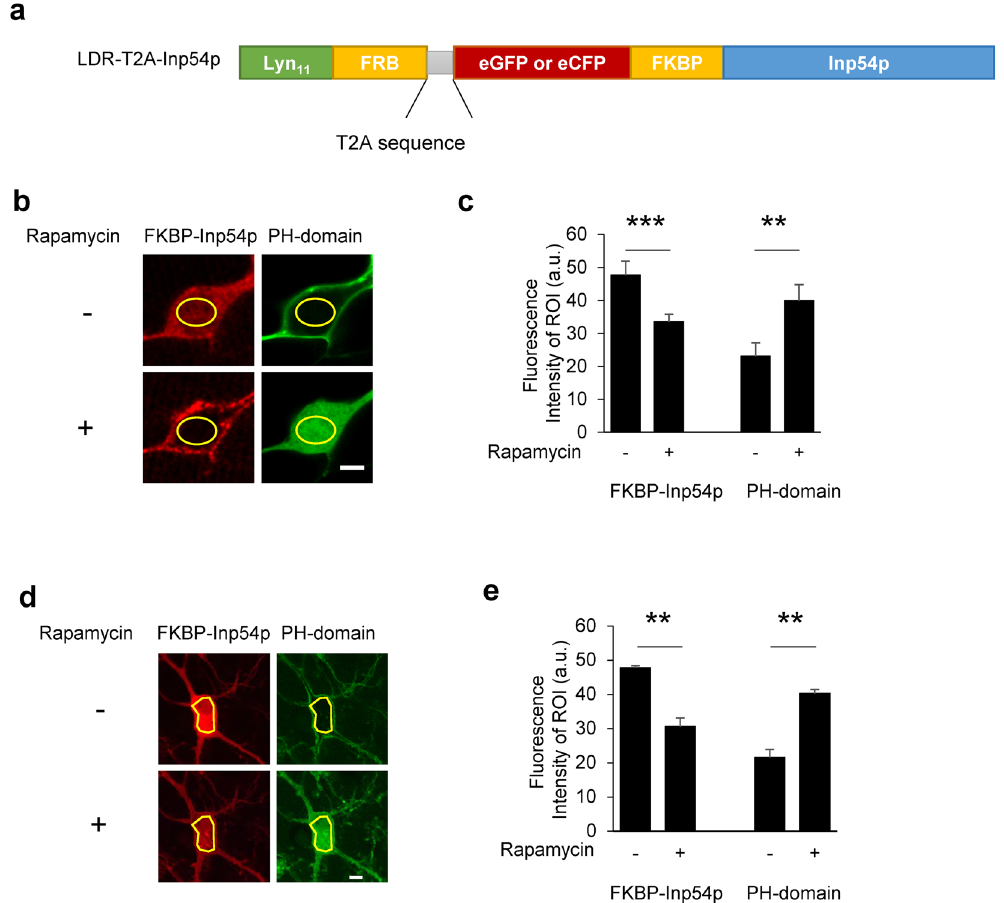
Figure 1. Validation of chemically induced dimerization for PIP 2 depletion using a single plasmid, LDR-T2A- Inp54p. ( a ) Schematic representation of the construct of the plasma membrane PIP 2 depletion system using a viral T2A peptide sequence linker. ( b ) Representative images of a HEK293T cell expressing LDR, FKBP-Inp54p (red), and PH-domain (green) before ( − ) and after ( + ) treatment with 100 nM rapamycin. Areas outlined with yellow lines represent the cytoplasmic region of interest (ROI). Scale bars: 5 μ m. ( c ) Mean fluorescence intensity of ROI in cells expressing LDR, FKBP-Inp54p, and PH-domain before and after treatment with 100 nM rapamycin in HEK293T cells (FKBP-Inp54p: 47.63 ± 4.30 vs . 33.53 ± 2.32, *** p < 0.001; PH-domain: 23.11 ± 4.09 vs . 39.92 ± 4.88, ** p < 0.01, N = 4, n = 20, Wilcoxon test). ( d ) A representative neuron expressing LDR, FKBP-Inp54p (red), and PH-domain (green) before ( − ) and after ( + ) 100 nM rapamycin treatment. Areas outlined with yellow lines represent the cytoplasmic region of interest (ROI). Scale bars: 10 μ m. ( e ) Mean fluorescence intensity of ROI in hippocampal neurons expressing LDR, FKBP-Inp54p, and PH-domain before and after 100 nM rapamycin treatment (FKBP-Inp54p: 47.80 ± 0.60 vs. 30.55 ± 2.57, ** p < 0.01; PH-domain: 21.54 ± 2.37 vs. 40.23 ± 1.26, ** p < 0.01, N = 2, n = 6, Wilcoxon